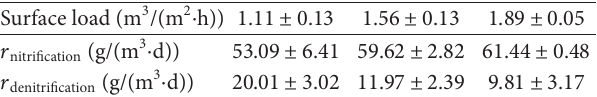
T 2: Nitri�cation anddenitri�cation rates in a DSTR at different surface